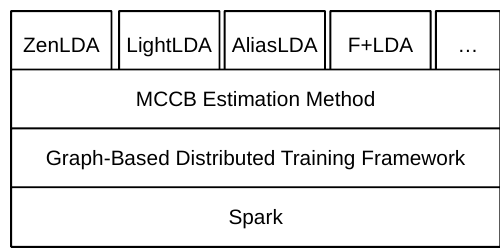
Fig. 3 The overall structure of our LDA training platform